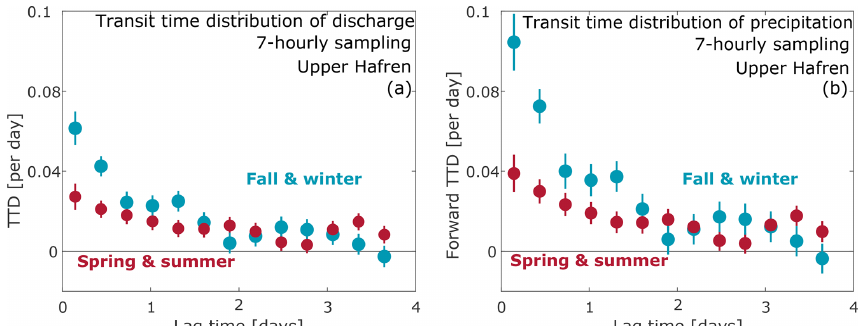
Figure 12. Transit time distributions of discharge (“backward” TTDs, a ), and precipitation (“forward” TTDs, b ) calculated from 7-hourly oxygen-18 measurements at Upper Hafren for the months of September–February (fall and winter, blue), and March–August (spring and summer, red). Fall–winter TTDs exhibit stronger coupling between precipitation and streamflow than spring–summer TTDs do, over lag times up to 1–1.5d but not longer. Fall–winter TTDs have larger error bars because there are more gaps in the source